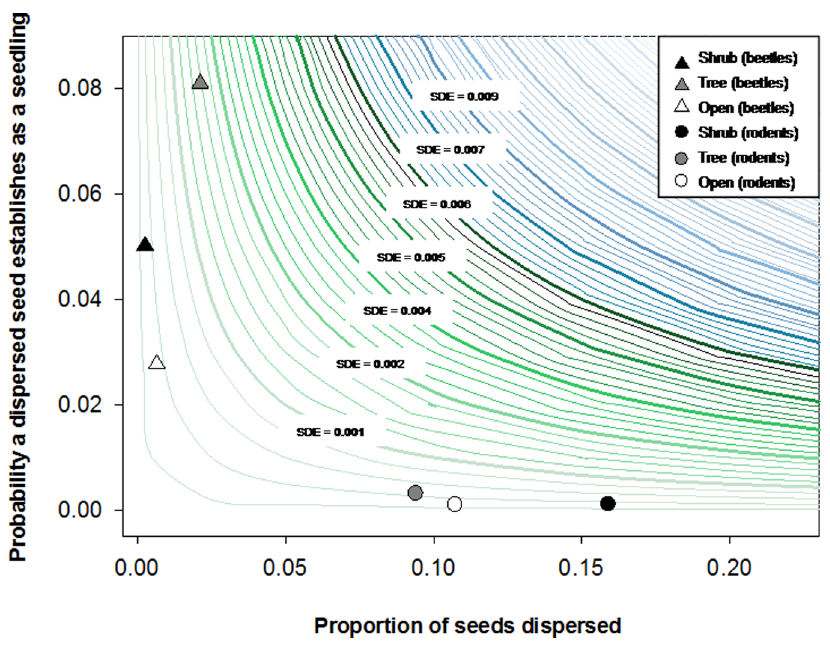
Figure 5. Two-dimensional representation of seed dispersal effectiveness (SDE) landscape. Isoclines represent all combinations of dispersal quantity ( x -axis) and quality ( y -axis) that yield the same SDE value. Symbols represent the position on the SDE landscape of the two dispersal agents (rodents represented by circles and beetles by triangles) depending on the microhabitat of origin (shrub in black, tree in grey and open in white colour).